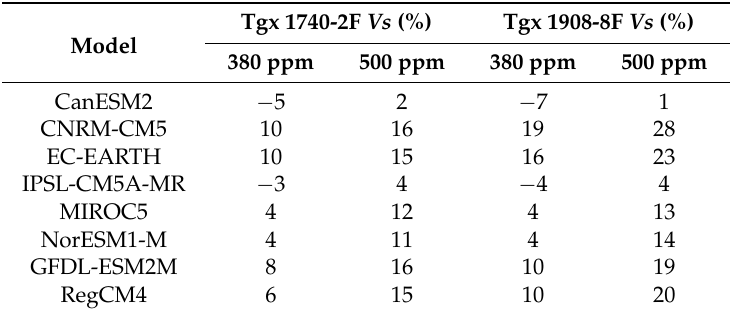
Table 8. Percentage change in productivity of the cultivar Tgx 1740-2F and Tgx 1908-8F for the 2014–2030 period compared to